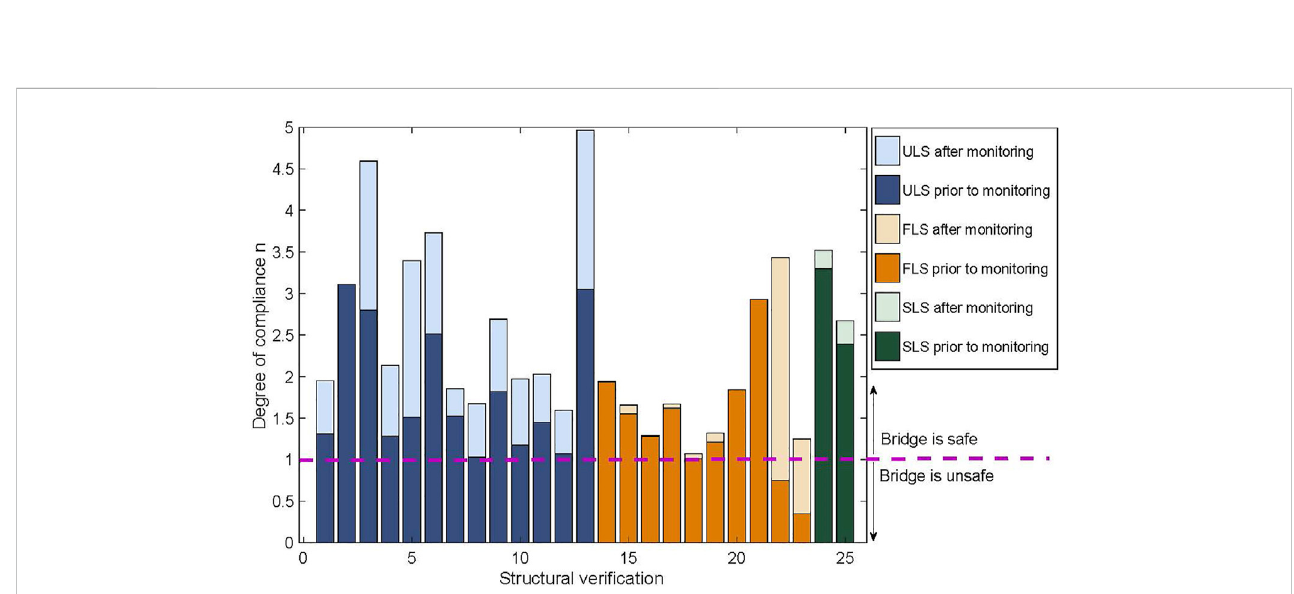
FIGURE 2 Evaluation of the degrees of compliance for structural veri fi cations of ultimate (ULS), fatigue (FLS), and service (SLS) limit states prior to and after monitoring.